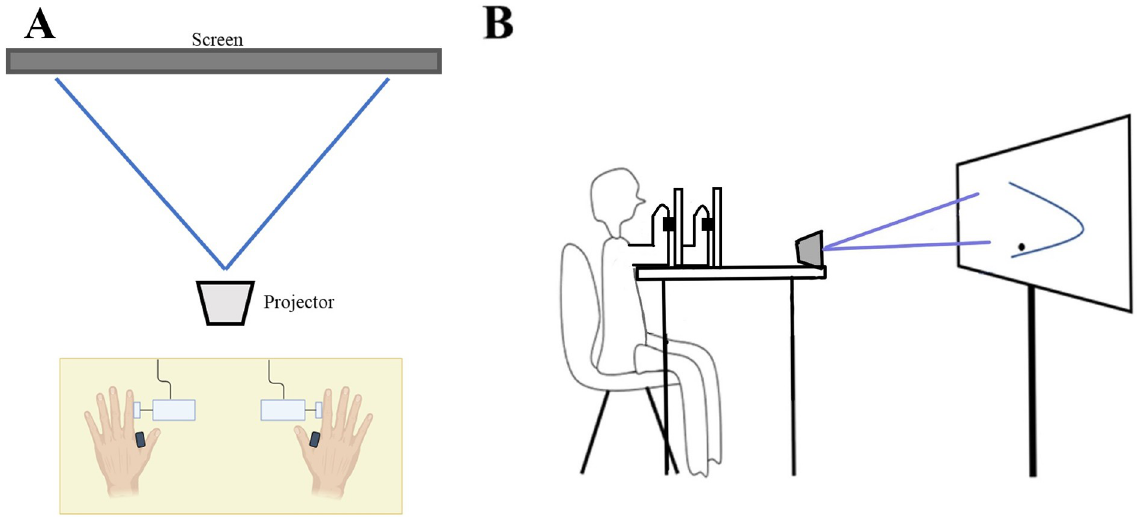
Fig 1. Experimental setup. (a) Illustration depicting experimental setup for bimanual task utilizing distal (FDI), and (b) proximal (TBI)